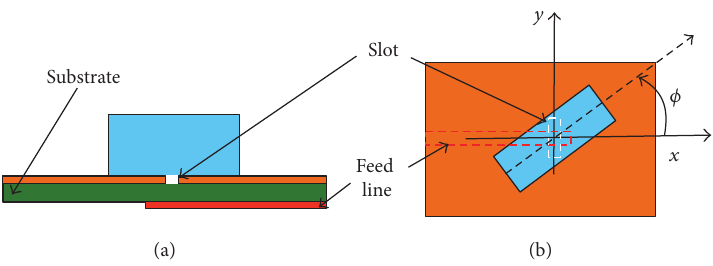
Figure 18: Cross-sectional view (a) and top view (b) of a rotated rectangular DRA as suggested in [34, 35].